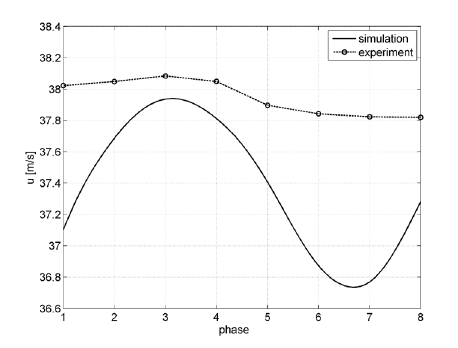
Fig. 8. Comparison of x component of velocity at point